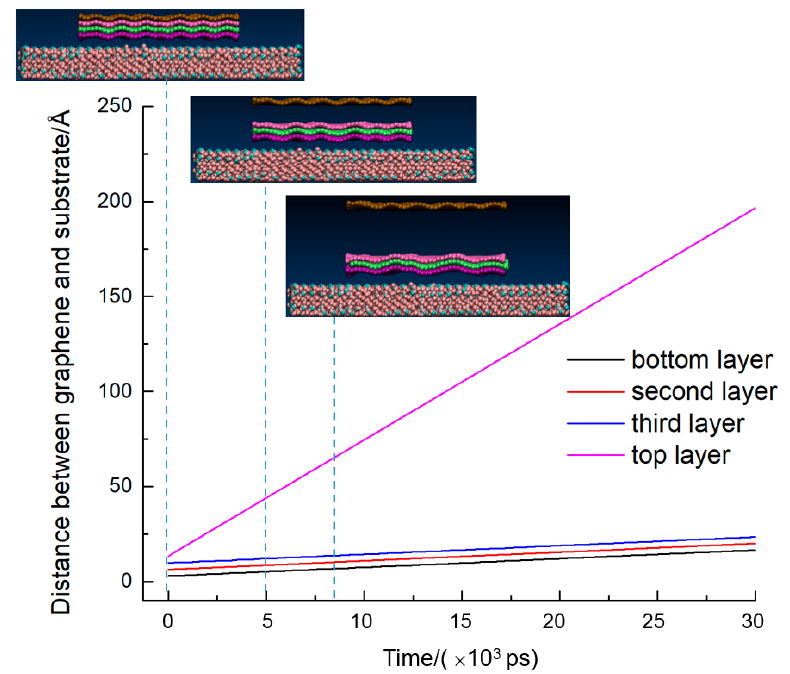
Figure 11. Exfoliation process in four-layer graphene system, when the vertical upward velocity was 15 Å/ps. The dotted blue line shows the trajectory at different points in time.